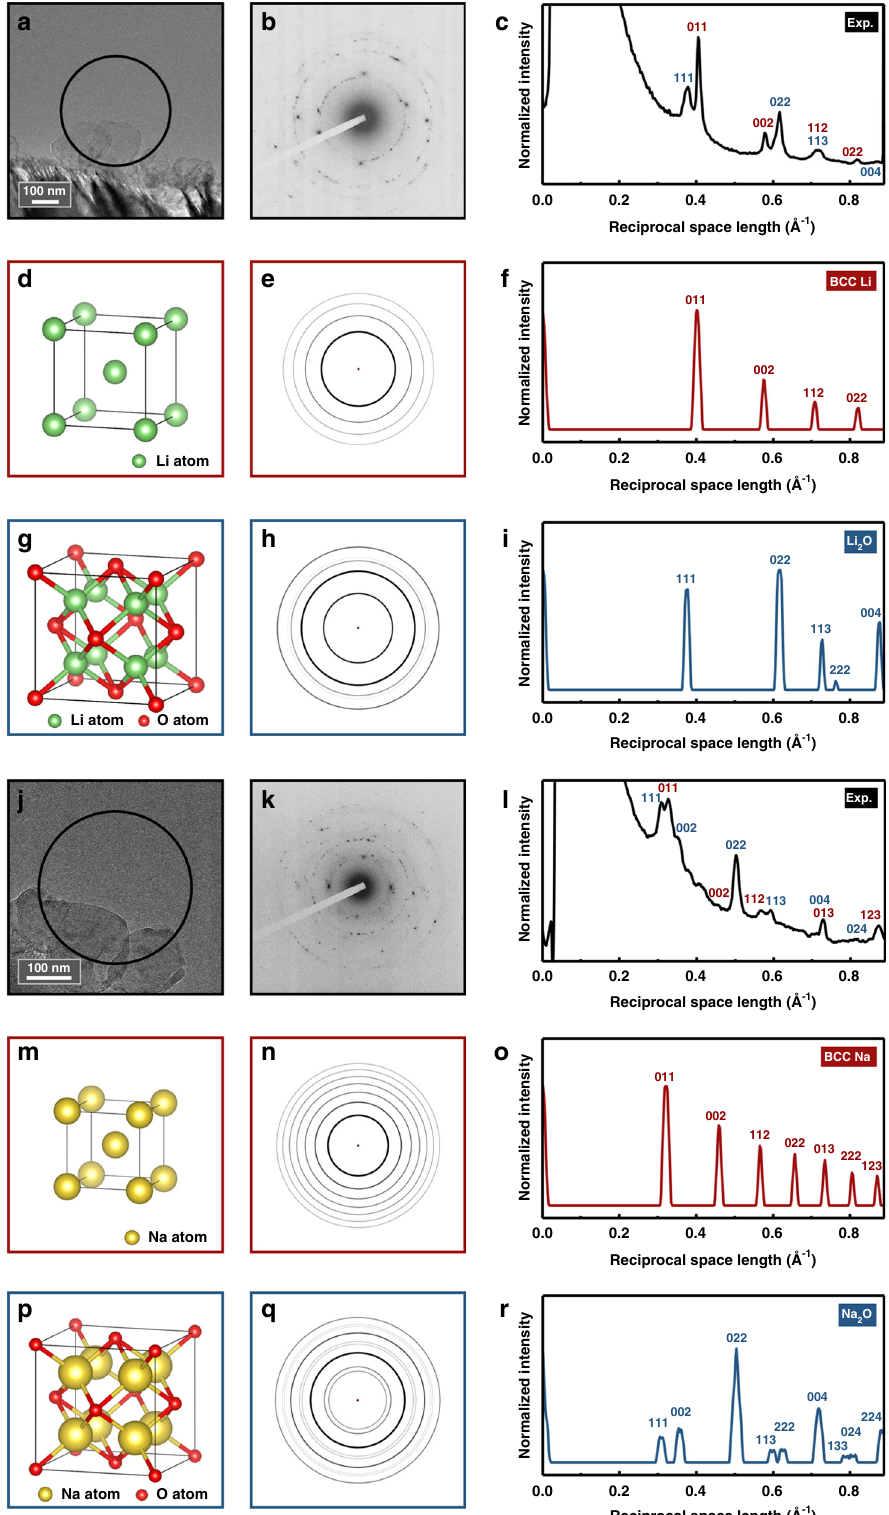
Fig. 2 SAED analysis of alkali metal particles. a The selected lithium particles (the black circle represents the aperture area), b its SAED pattern and c rotational average spectrum. d Crystal structure of b.c.c. lithium, e its simulated polycrystalline diffraction rings and f rotational average spectrum. g Crystal structure of f.c.c. lithium oxide, h its simulated polycrystalline diffraction rings and i rotational average spectrum. j The selected sodium particles, k its SAED pattern and l rotational average spectrum. m Crystal structure of b.c.c. sodium, n its simulated polycrystalline diffraction rings and o rotational average spectrum. p Crystal structure of f.c.c. sodium oxide, q its simulated polycrystalline diffraction rings and r rotational average